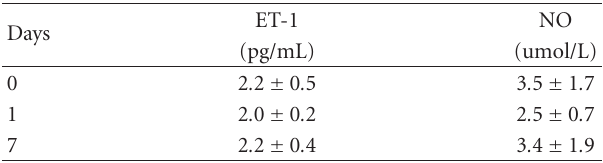
Table 2: Plasma endothelin (ET)-1 and nitric oxide (NO) concen- trations before and after the surgery.